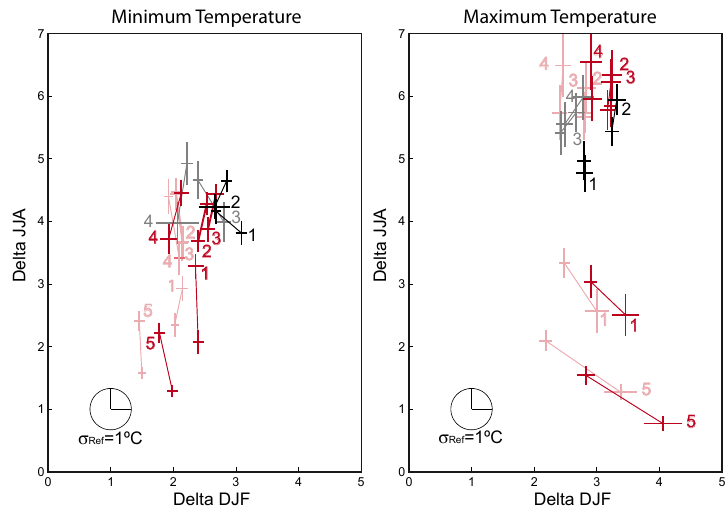
Fig. 6. As in Fig. 5, but for the period